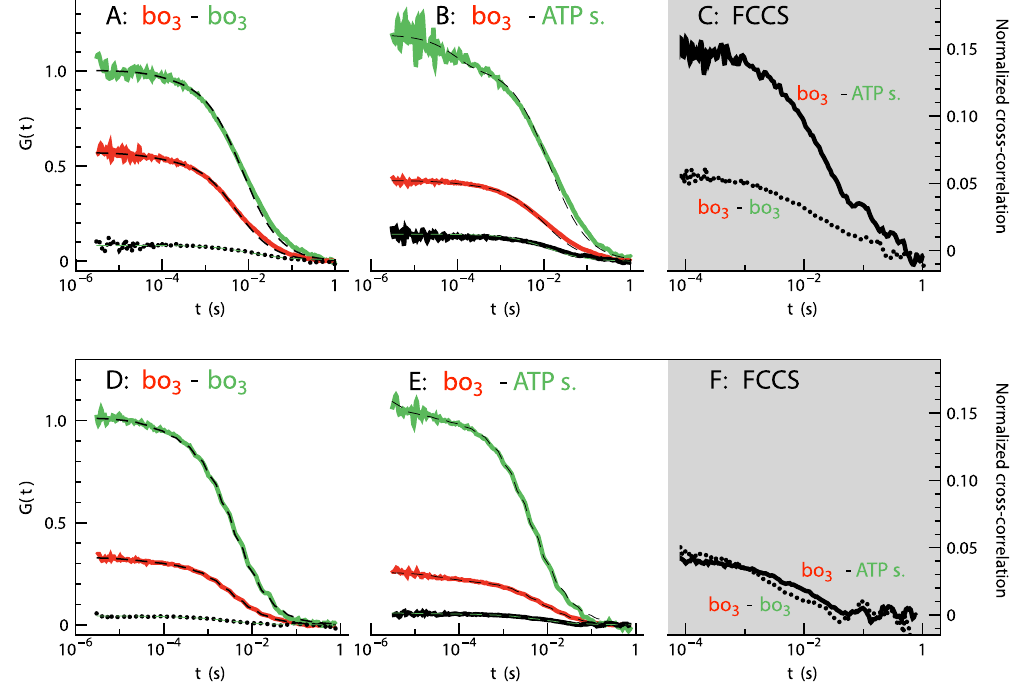
Figure 3. Auto-correlation data measured with GUVs containing co-reconstituted cyt. bo 3 and ATP synthase. GUVs were composed of either 99% DOPC ( A – C ) or 94% DOPC and 5% DOPG ( D – F ), with the addition of 1% DPPE functionalized with a biotinyl head group. Measurements were done at pH 7.4 in 10 mM HEPES supplemented with 10 mM NaCl and 100 mM glucose. ( A , D ) FCS was used to study samples where cyt. bo 3 was labeled with either ATTO 647N (red trace) or ATTO 594 (green trace). ( B , E ) samples with cyt. bo 3 labeled with ATTO 647N and ATP-synthase labeled with ATTO 594. The dashed lines represent best fits of the data using a single component with planar two-dimensional diffusion and a triplet state fraction. The amplitude of the diffusional component obtained from the fit of the data with the ATTO 594-labeled protein has been set to unity (amplitude at ~10 − 4 s) to facilitate comparison of the traces. The autocorrelation function for FCCS was calculated in all cases and the normalized cross correlation amplitudes are compared in panels ( C ) and ( F